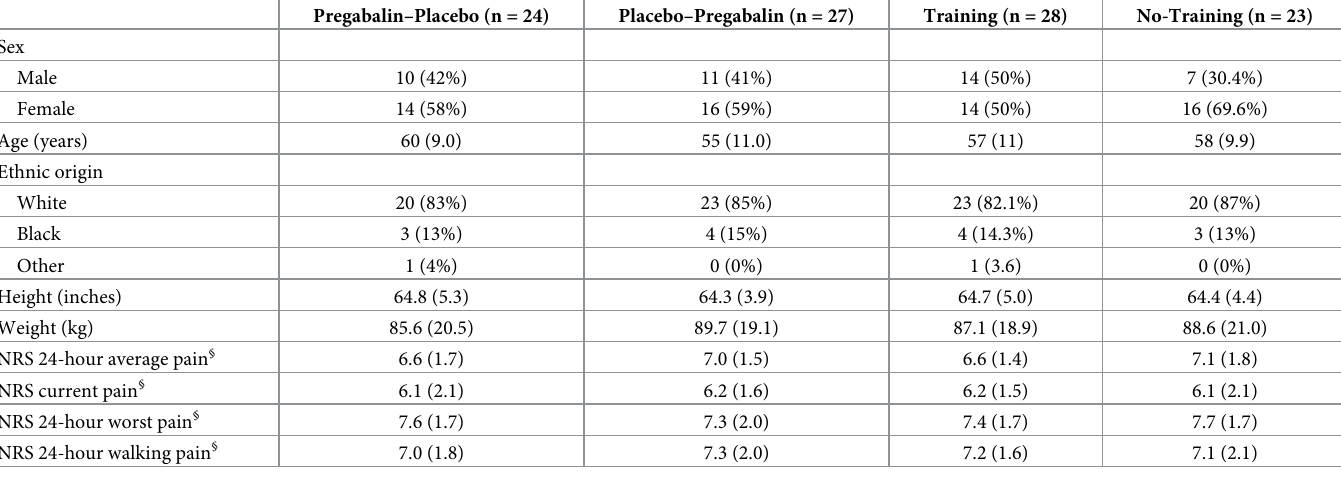
Table 1. Baseline characteristics of the per-protocol